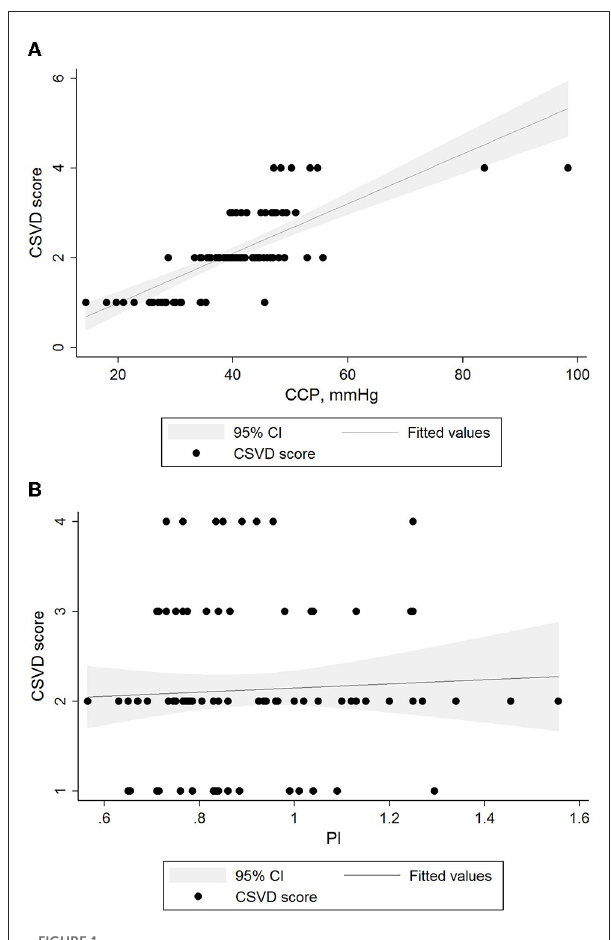
FIGURE1 Relationships between levels of hemodynamic parameters and CSVD burden. Black lines and gray shadows represent the estimated probability and 95% CIs for the CSVD scores at the level of methods on the basis of the generalized additive model. The x axis is limited from the 5th to the 95th percentile of the level of the hemodynamic parameter. (A) CSVD scores and CrCP β = 0.05 (95% CI 0.04 to 0.06, p < 0.01). (B) CSVD scores and PI β = − 0.76 (95% CI − 1.63 to 0.12, p = 0.091). CI, confidence interval; CSVD, cerebral small vessel disease; PI, pulsatility